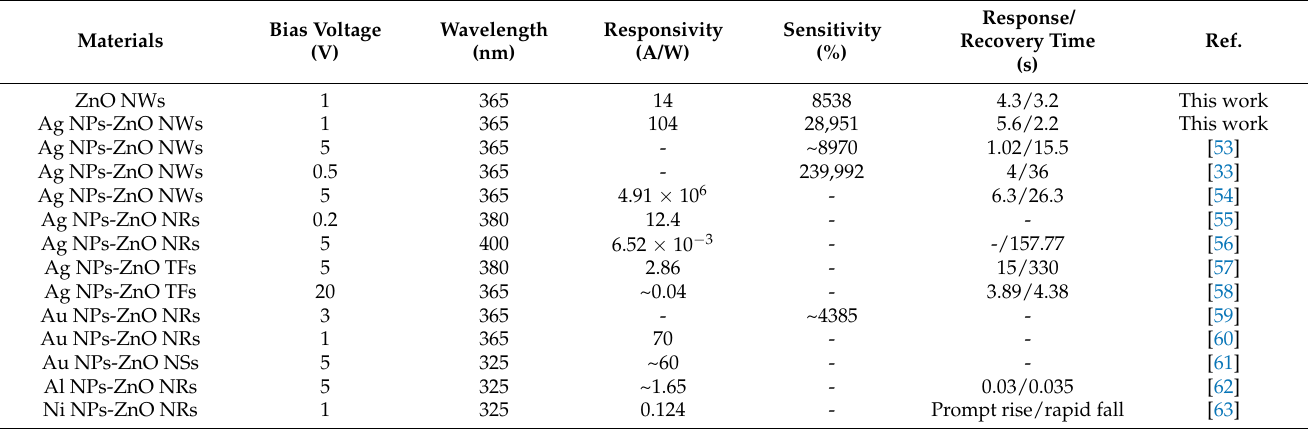
Table 1. Comparison of performances of ZnO nanostructure UV PDs decorated with metal NPs.